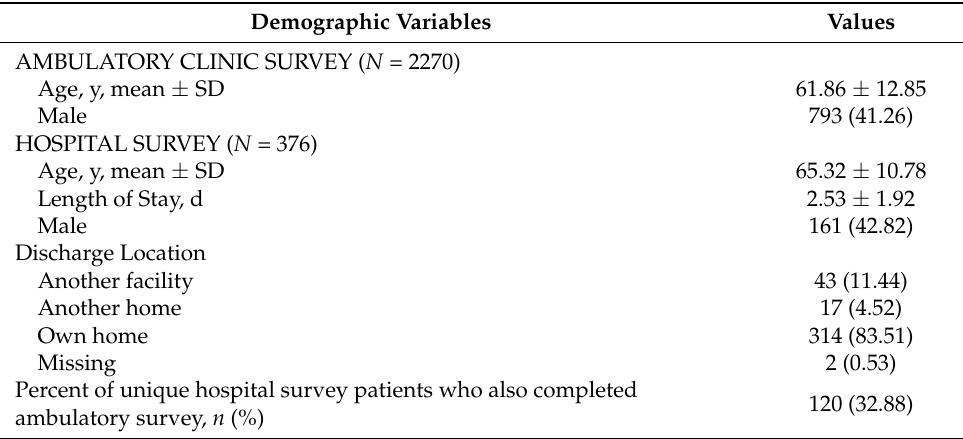
Table 1. Press Ganey survey participant